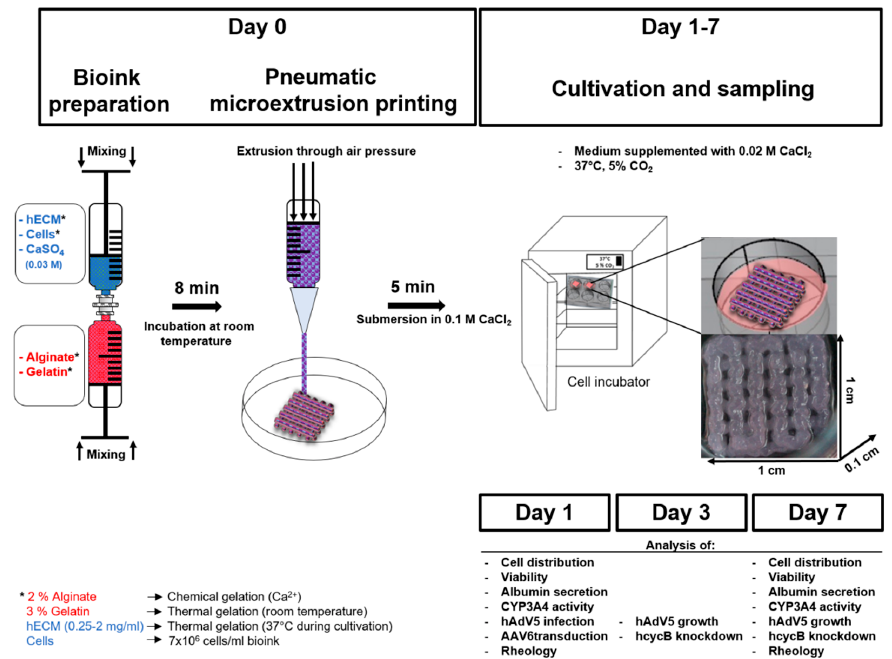
Figure 1. Experimental design of bioprinting and processing of cell-laden hybrid alginate/gelatin/human extracellular matrix (hECM) constructs. Schematic workflow of the 3D printing procedure.